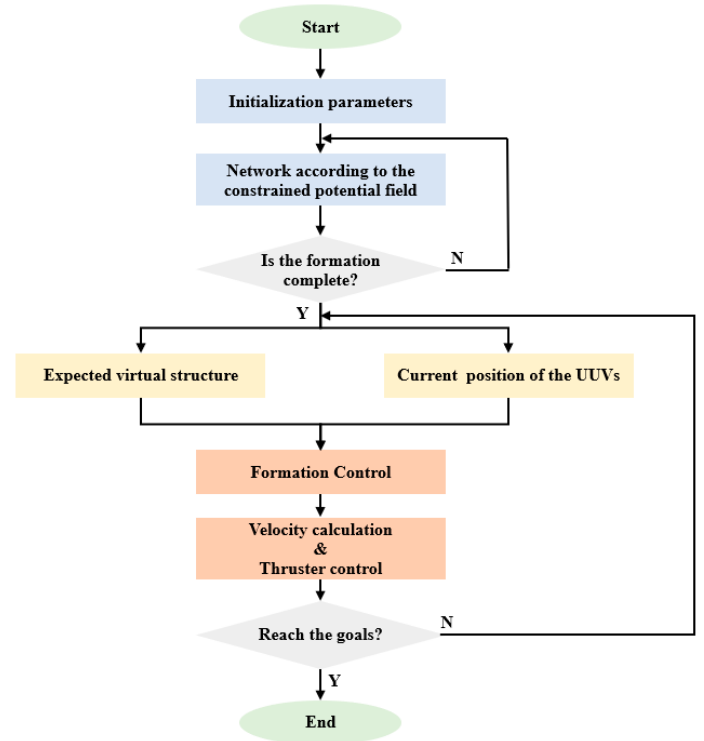
Figure 12. Flow chart of target-hunting simulation experiment.